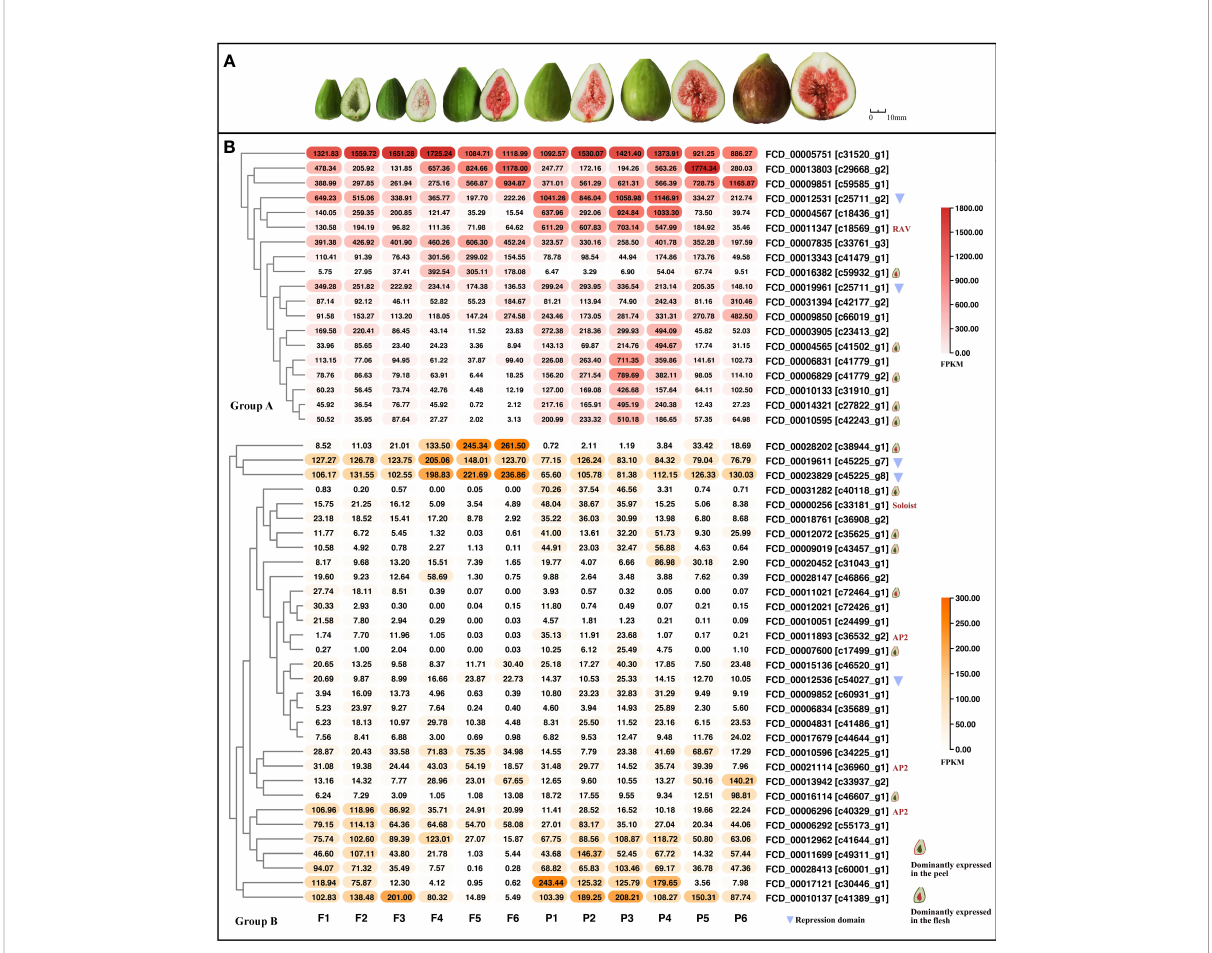
FIGURE 5 Expression patterns of FcAP2/ERF genes during fi g fruit development. FcAP2/ERF genes were divided into three groups based on expression levels: group A (maximum FPKM between 300 and 1800), group B (maximum FPKM between 20 and 300) and group C (maximum FPKM ≤ 20). (A) Six stages of fi g fruit development. (B) Expression patterns of genes in groups A and (B) Members of group C are shown in Supplementary Figure